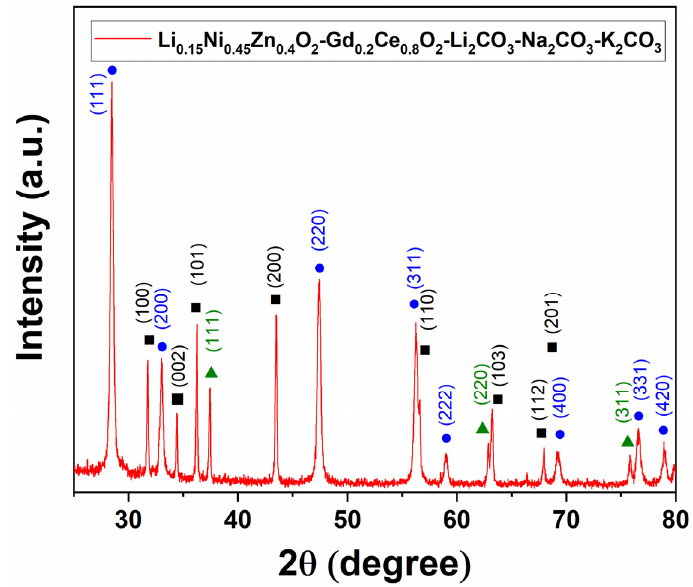
Figure 3. The XRD pattern of the Li 0.15 Ni 0.45 Zn 0.4 O 2 -Gd 0.2 Ce 0.8 O 2 -Li 2 CO 3 -Na 2 CO 3 -K 2 CO 3 composite material after calcination at 800 °C in air for 3 h. This composite material was used to fabricate all the cells, which were sintered for 2 h at a temperature of 700 °C to 1000 °C. The symbols represent different materials: ● Gd 0.2 Ce 0.8 O 2 , ▲ LiNiO 2 , ■ LiZnO 2 .